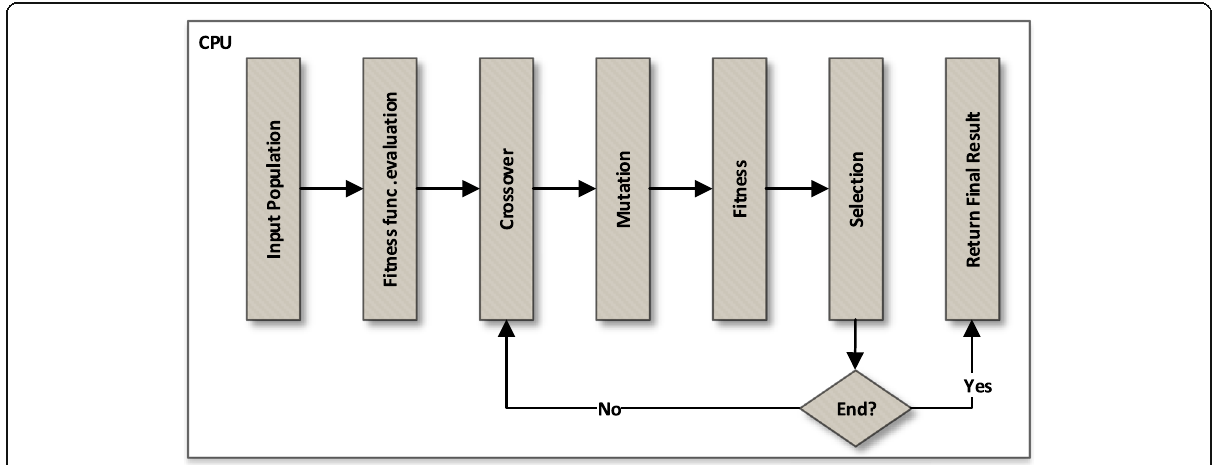
Fig. 3 Sequential approaches for running Genetic